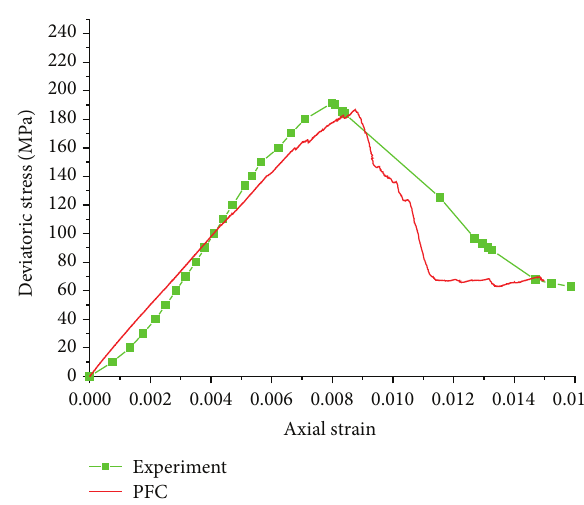
Figure 7: The comparison between numerical test and experiment.